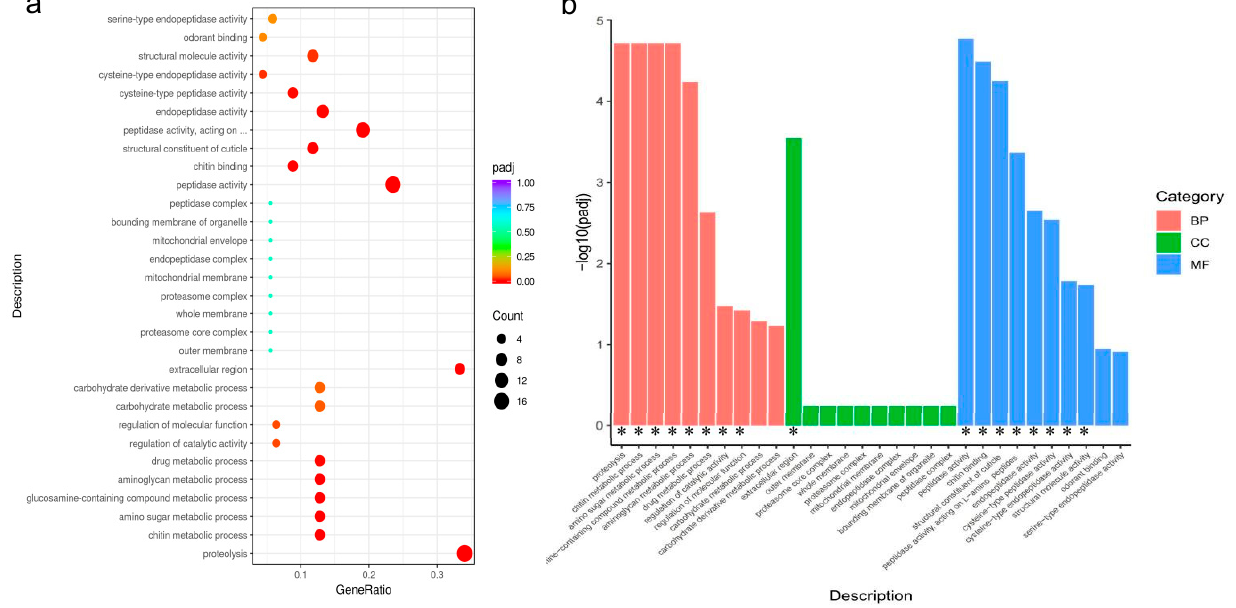
Figure 3. ( a , b ): GO enrichment of the DEGs. BP, biological process; CC, cellular component; MF, molecular function, using padj < 0.05 as the threshold for significant enrichment. * Indicates that DEGS is significantly enriched in this pathway.